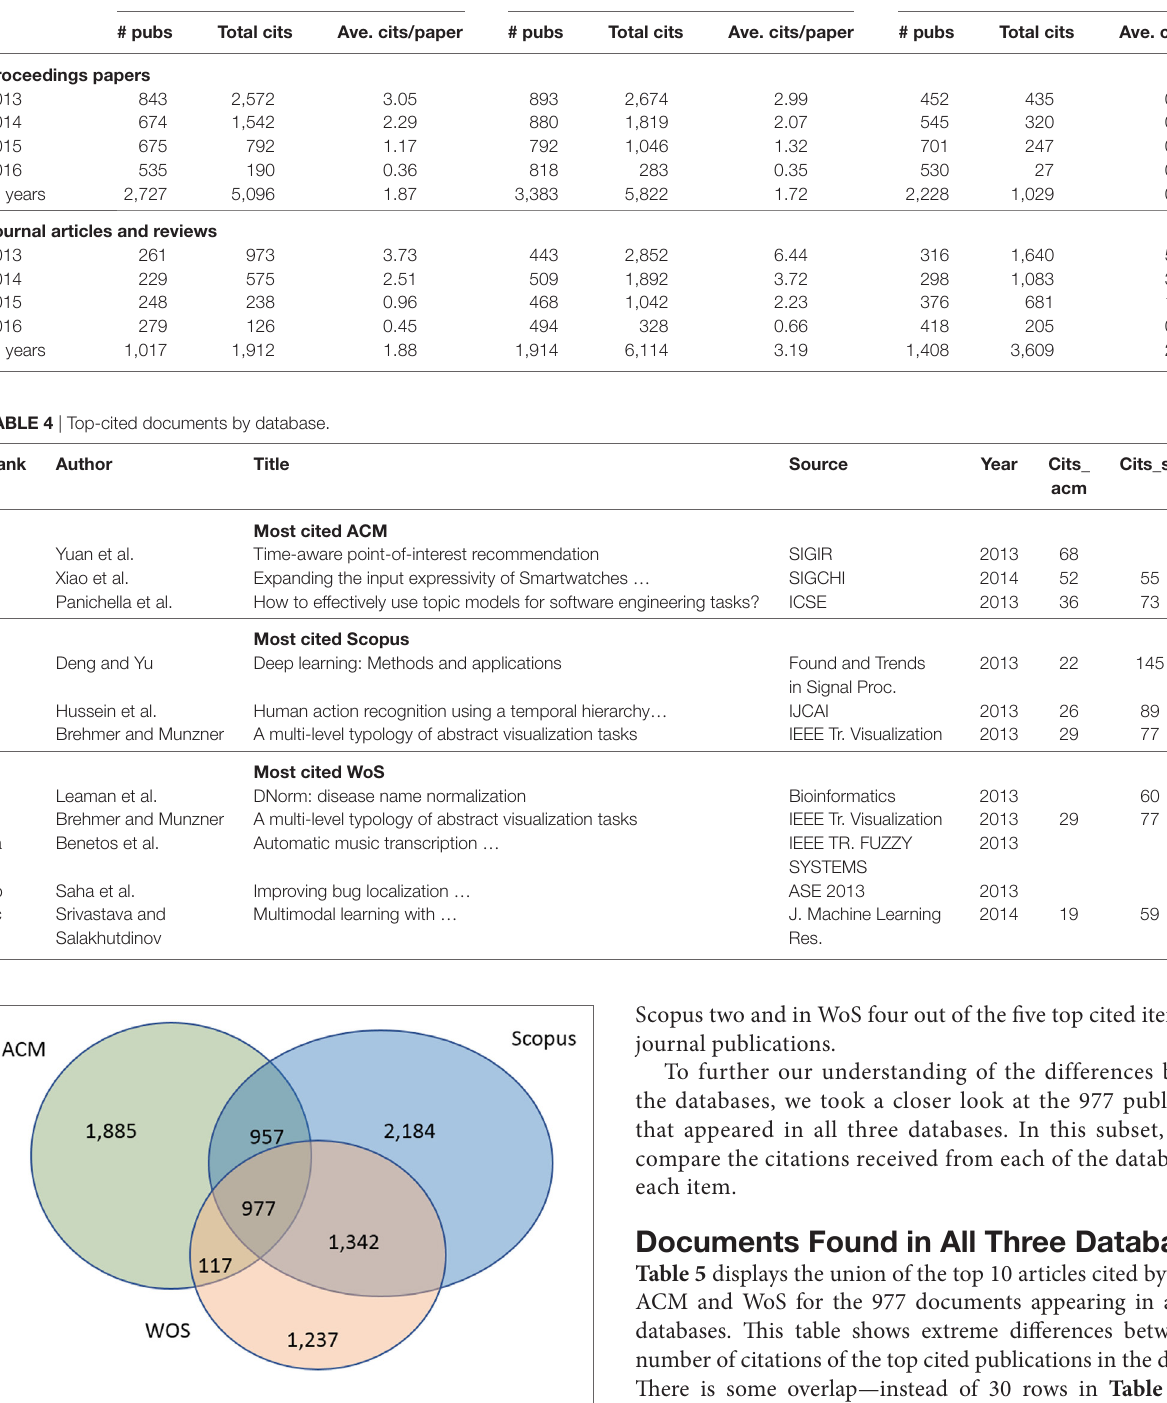
FiGurE 2 | Overlap between the databases.